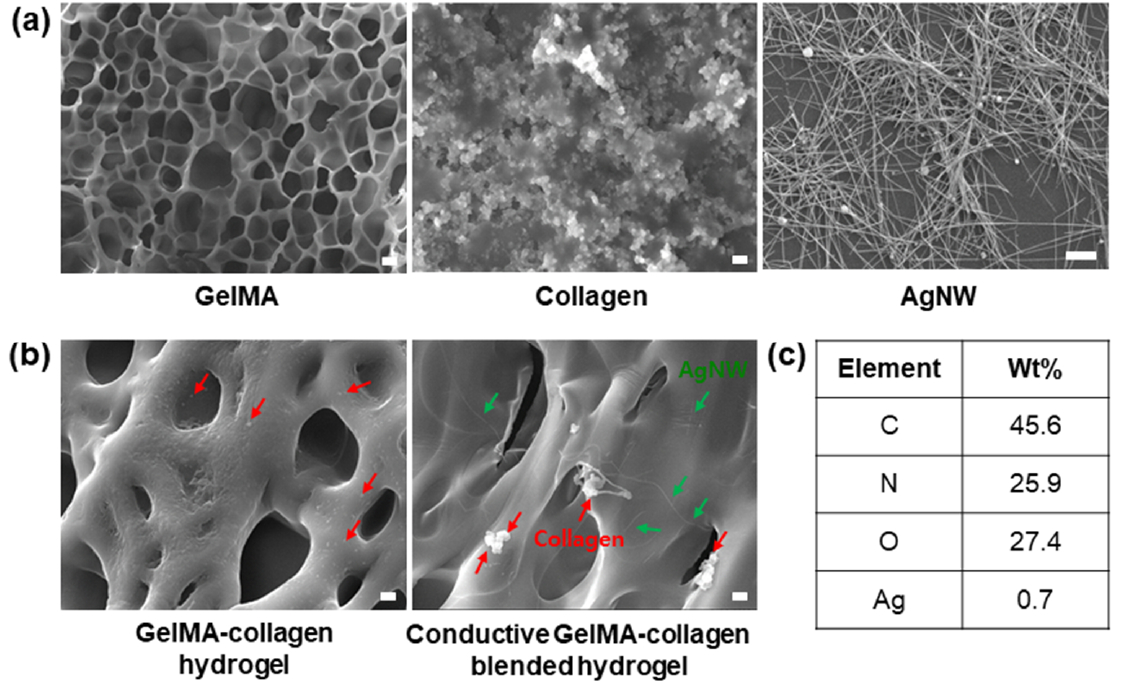
Figure 2. Scanning electron microscope (SEM) images of the conductive GelMA–collagen–AgNW blended hydrogel. SEM images of GelMA, collagen, and AgNW ( a ). SEM images of the conductive GelMA–collagen–AgNW blended hydrogel ( b ). Energy dispersive X-ray spectrometer (EDS) analysis of the conductive GelMA–collagen–AgNW blended hydrogel (Green arrow is AgNW, red arrow is collagen) ( c ). The all scale bars are 1 µm.